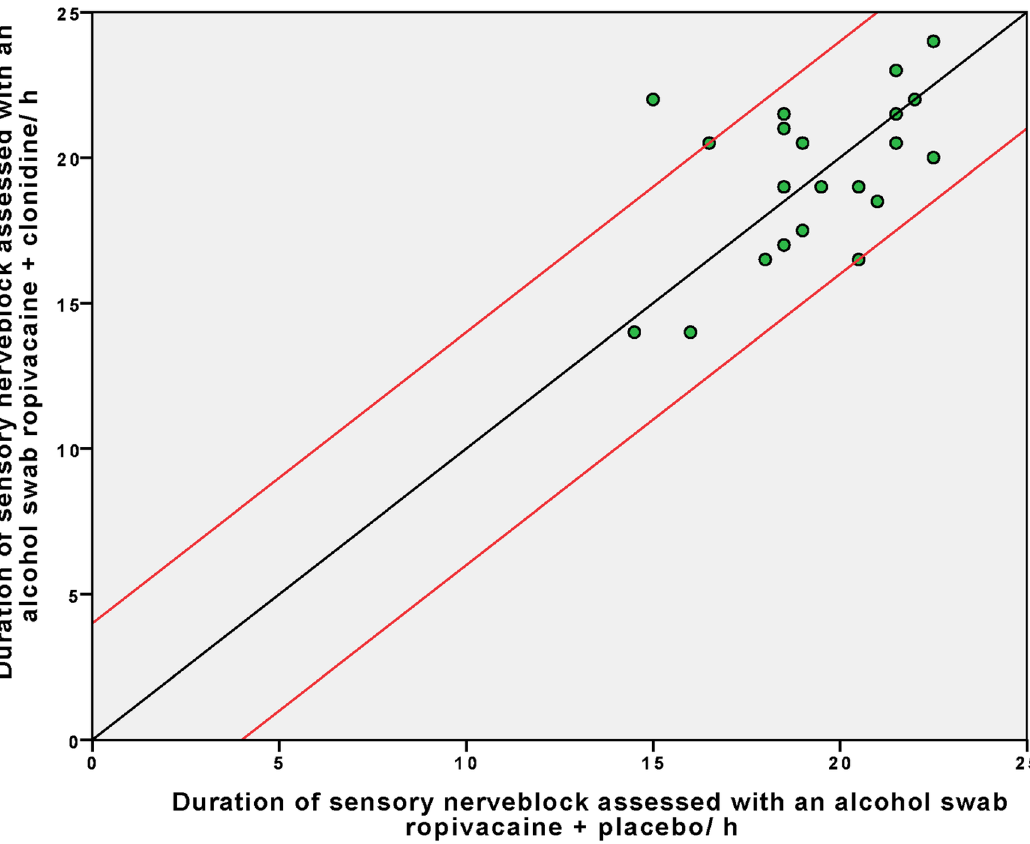
Fig 2. Differencein duration of sensory block between clonidine and placebo assessed using an alcohol swab. Each dot representsthe sensory durationof the two blocks from one volunteer, with the ropivacaine + placeboblock along the X-axis and ropivacaine + clonidine block along the Y- axis. The black reference line indicatesno difference in duration of sensory block betweenthe block receivingclonidineand placebo. Dots above the reference line indicate an advantage of addingclonidineperineurally, dots below indicatean advantage of placebo. The red lines indicate the a priori defined minimalrelevantdifference of four hours.